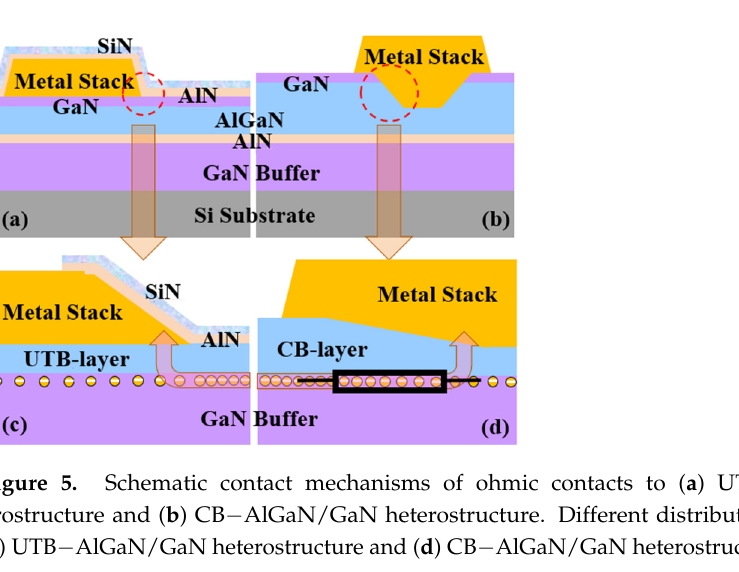
Figure 4. TEM cross − sectional view on ( a ) UTB and ( b ) CB − AlGaN/GaN heterostructure; EDS map- ping of the ohmic contact on ( c ) UTB and ( d ) CB − AlGaN/GaN heterostructure; Line scan of the ohmic contact on ( e ) UTB and ( f ) CB − AlGaN/GaN heterostructure.